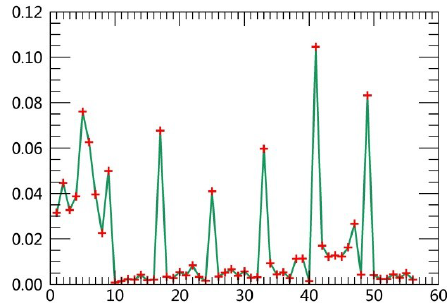
Figure 5. Weight line chart of 54 features in 2010.